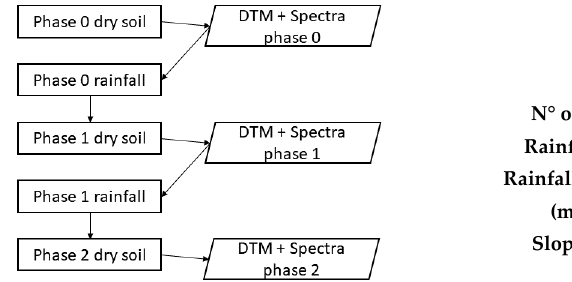
Figure 1. Data series structure ( left ) and variables ( right ).